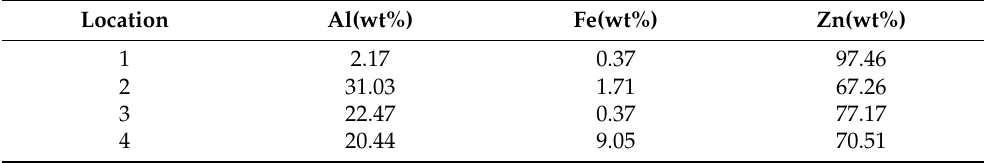
Figure 5. Organization of 475-45-W hot dip plating layer under SEM, ( a ) Cross-sectional morphol- ogy of hot dip plating layer tissue; ( b ) Analysis of enriched areas and micro-areas in a large num- ber of lamellar tissue of the reaction layer of hot dip plating layer. Table 8. Point scan and surface scan results of 475-45-W hot dip coating layer.